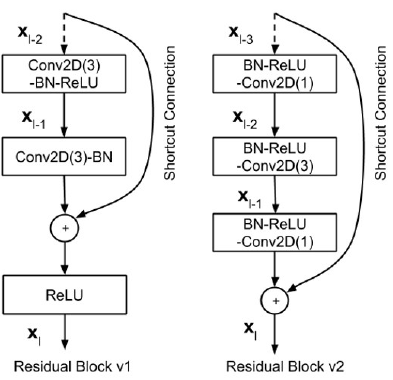
Figure 8. Illustrating convolutional block of ResNet.